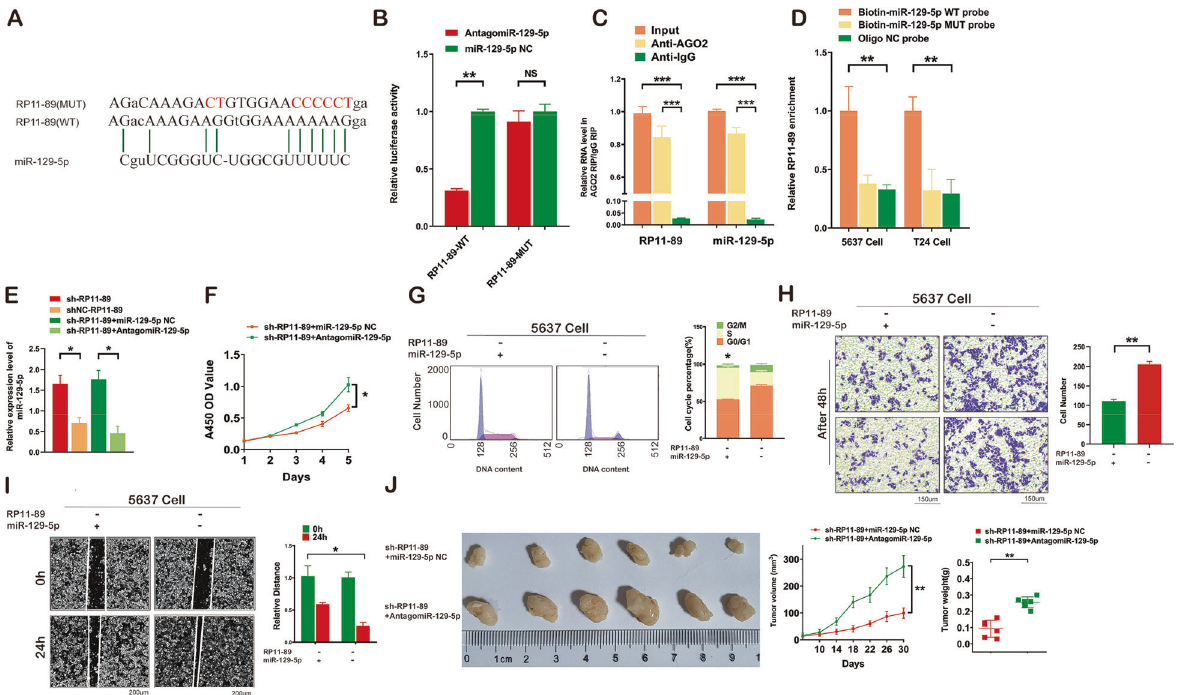
Fig. 4 RP11-89 promotes tumorigenesis via sponging miR-129-5p in BLCA. A The binding sites between miR-129-5p and MUT/WT of RP11- 89. B Dual luciferase assay showed that RP11-89 down-regulated miR-129-5p and miR-129-5p downregulated PROM2. C RIP assay con fi rmed the interaction of miR-129-5p with RP11-89 in BLCA cells. D RNA pull-down assay showed that RP11-89 was enriched in the sample pulled down by the Bio-miR-129-5p WT probe in 5637 Cell and T24 Cell. E The expression level of miR-129-5p in each group transfected as indicated was veri fi ed through RT-qPCR. F CCK-8 assay indicated that inhibition of miR-129-5p restored cell proliferation in RP11-89 knockdown cells. G Cell cycle analysis indicated the percentage of G2/M phase, S phase and G0/G1 phase cells in each group transfected as indicated. H Transwell assay revealed that inhibition of miR-129-5p restored the migration ability in RP11-89 knockdown cells. I Scratch test showed the migration capacities of cells transfected as indicated. J Representative images of tumors from nude mice inoculated with BLCA cells and inhibition of miR-129-5p increased tumor volume and tumor weight of nude mice after inoculation. Results are presented as mean ± SD. * P < 0.05; ** P < 0.01, *** P < 0.001, **** P < 0.0001. Data were obtained from at least three independent